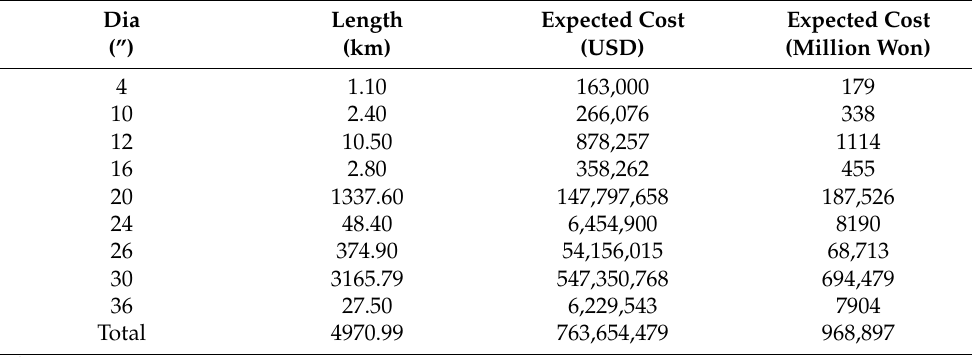
Table 5. Expected cost of hydrogen pipeline construction based on Scenario 1.